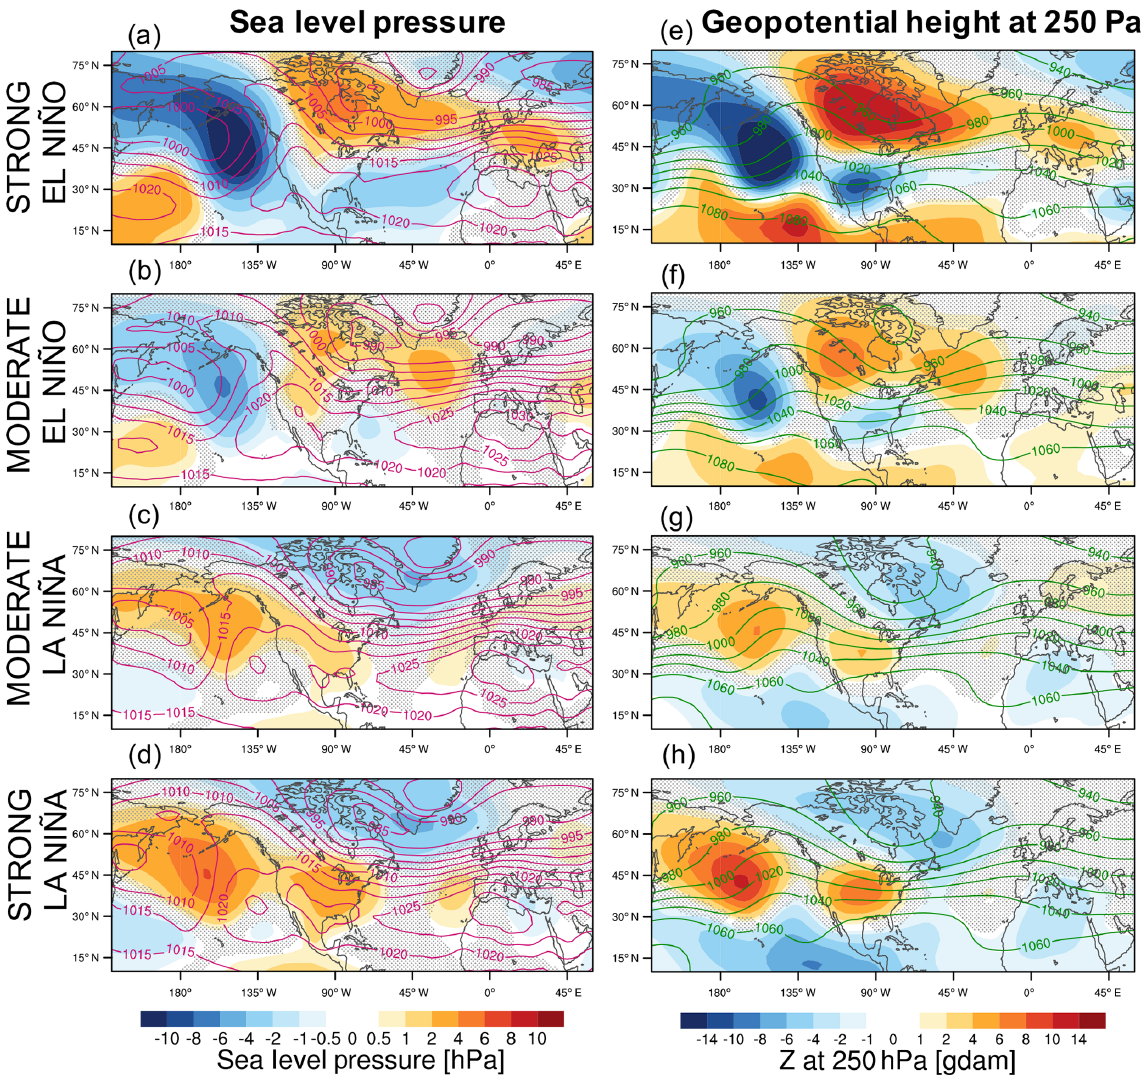
Figure 2. (a–d) DJF SLP and (e–h) DJF mean Z250 model response for the nudged stratosphere simulations with (a, e) strong EN, (b, f) mod- erate EN, (c, g) moderate LN, and (d, h) strong LN forcing. Contour lines indicate absolute values of SLP (hPa) and Z250 (gdam: geopotential decameters). Non-statistically significant values below the 95% confidence level are dotted in